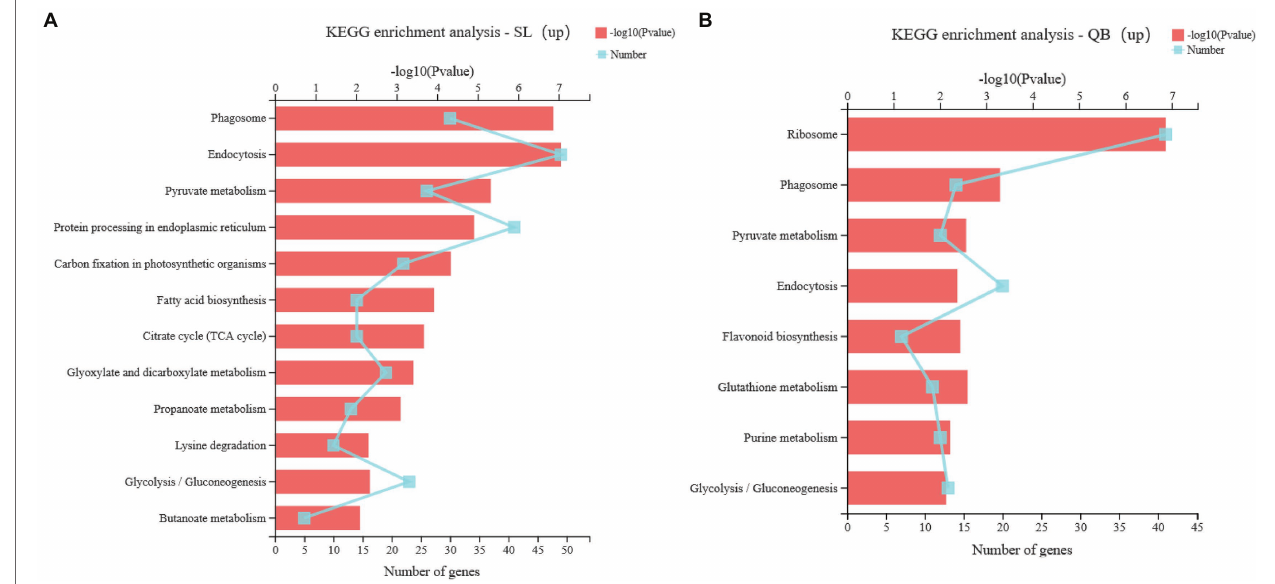
FIGURE 9 | KEGG pathway enrichment of upregulated gene sets in Swan Lake (SL; A ) and Qingdao Bay (QB; B ). The vertical axis represents the name of KEGG Pathway; the lower abscissa represents the number of genes in this pathway, corresponding to different points on the broken line, the upper abscissa represents the significance level of enrichment, corresponding to the height of the column; the larger the value of – log10 (value of p ) is, the more significantly enriched the KEGG pathway is.